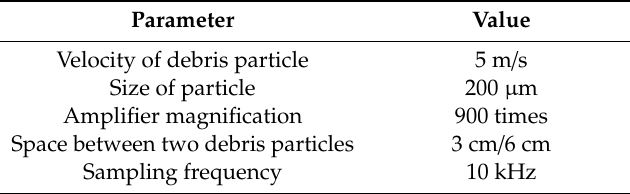
Figure 12. Real wax block experimental system. Table 5. Parameters of the experimental system